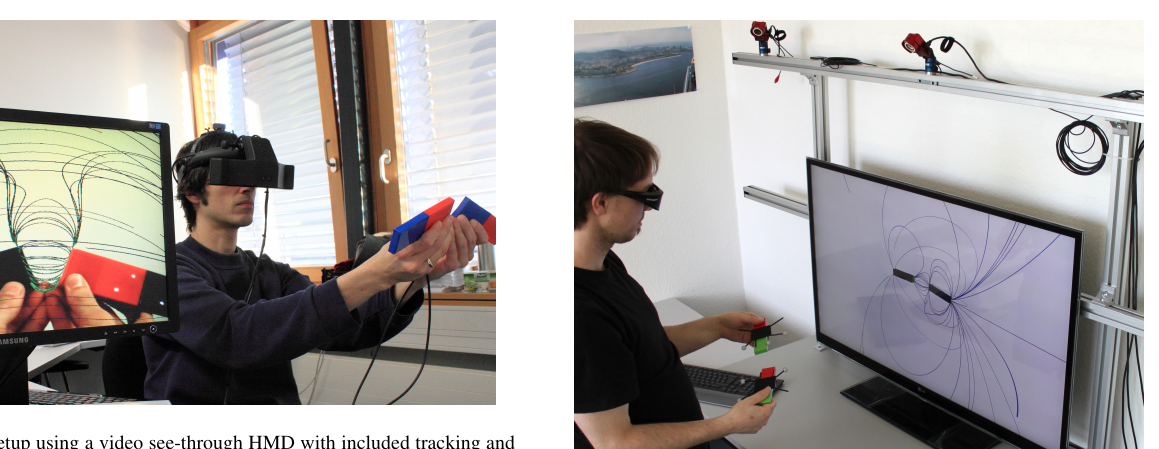
Fig. 4. AR setup using a video see-through HMD with included tracking and real magnets as interaction device. The separate monitor displays the image generated for the user’s left eye. Fig. 5. VR setup using an active stereo LCD-TV, optical tracking and real magnets with tracking markers as interaction devices.